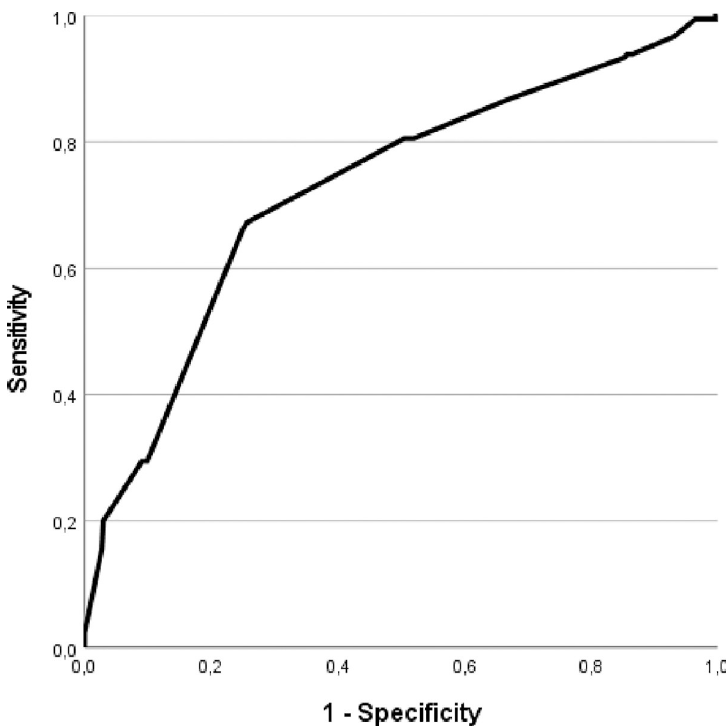
Fig 1. ROC curve to determine the optimal cut-off point of the CVR. ROC curve regarding the CVR, based on the outcome of interest, with an AUC of 73% (68% to 77%) and optimal cut-off point of 0.41 (100-specificity 0.26 and sensitivity